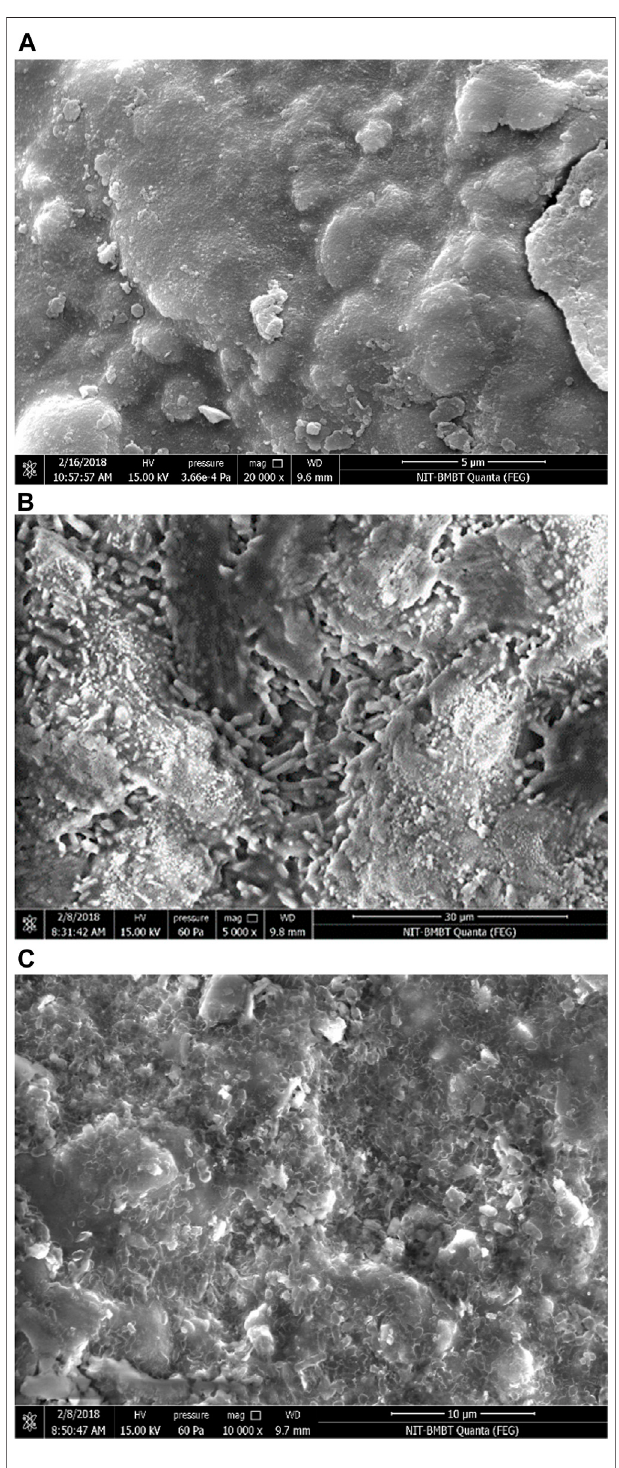
FIGURE 1 | ESEM micrographs of ceramic raschig rings (A) without bio fi lm; (B) with bio fi lm Day 15; (C) with bio fi lm Day 70.